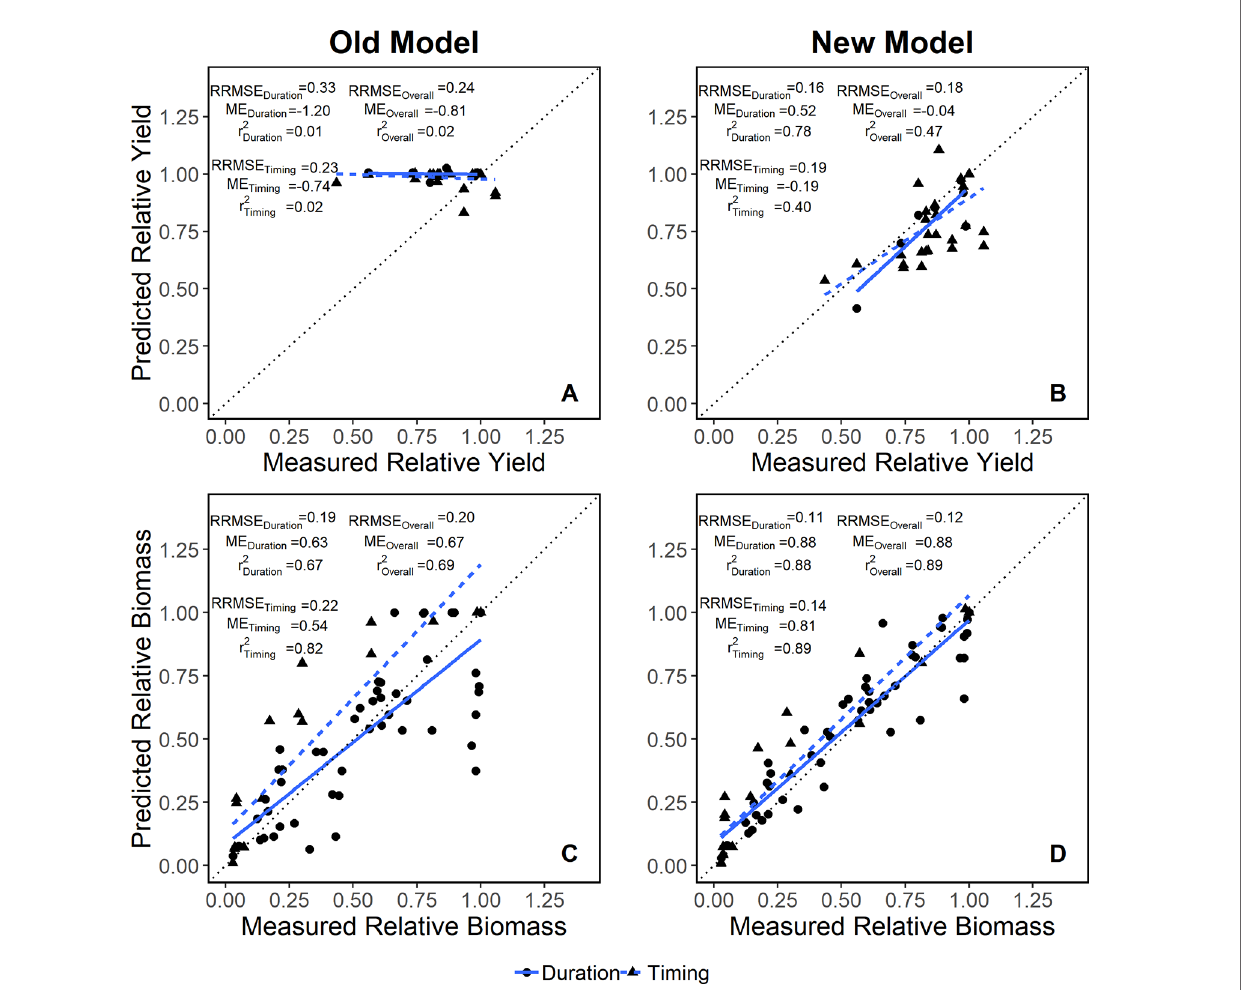
FIGURE 2 | Model evaluation for yield (A, B) and biomass (C, D) data in both fl ooding duration (solid blue line) and timing (dashed blue line) studies relative to a 1:1 reference line (dotted black line). Relative root mean square error (RRMSE), modeling ef fi ciency (ME) and R 2 for each dataset are included in the